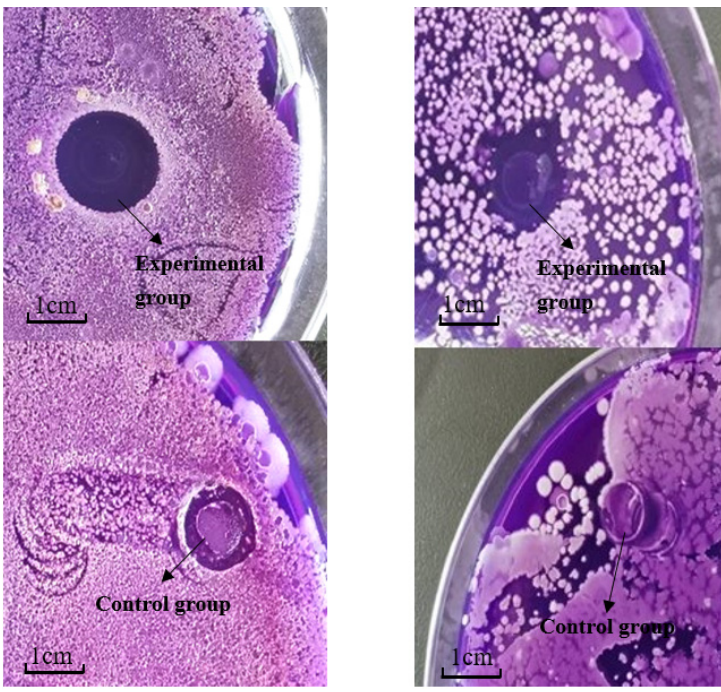
Figure 1. Size of the inhibition zone of the two strains.